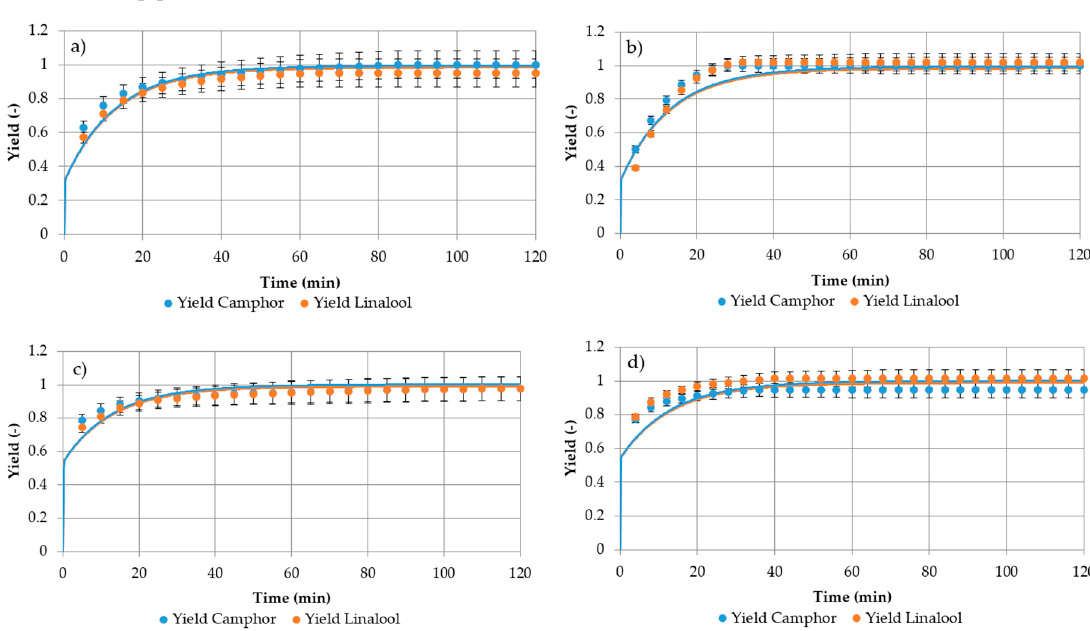
Figure 18. Corner points of the experimental design for lavender. ( a ): 1 mL / min / 1.8 g; ( b ): 7 mL / min / 1.8 g; ( c ): 1 mL / min / 5.6 g; ( d ): 1 mL / min / 5.6 g.